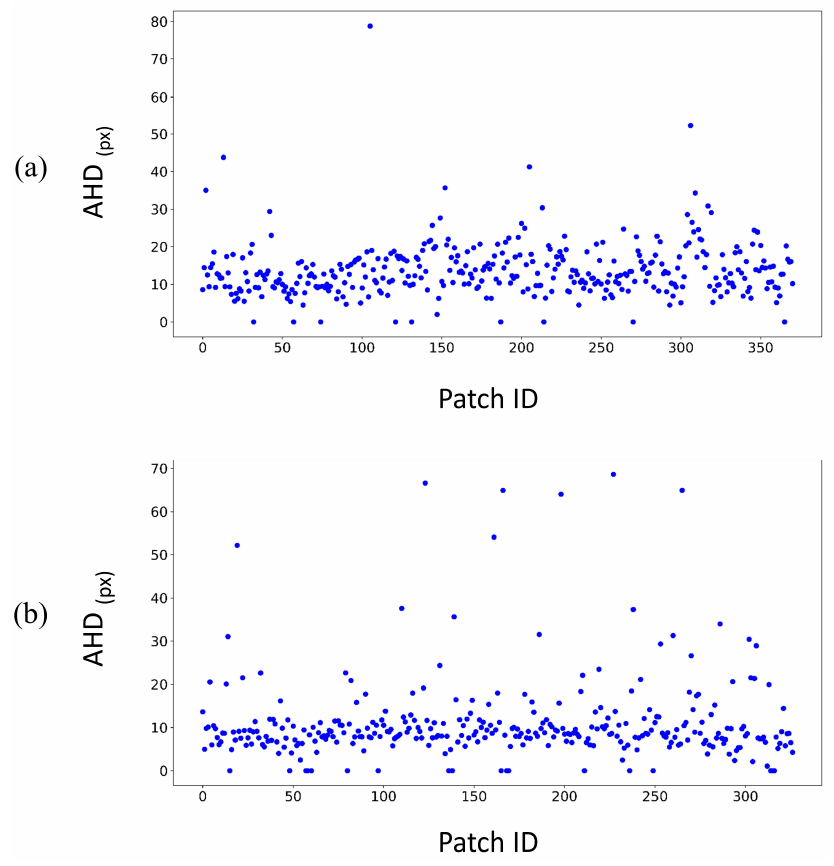
Figure 16. AHD values for each image patch in the first (a) and second datasets ( b ).